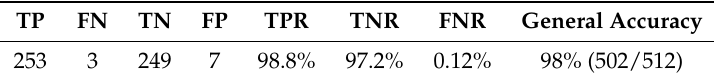
Table 7. Performance of Fire Net on test